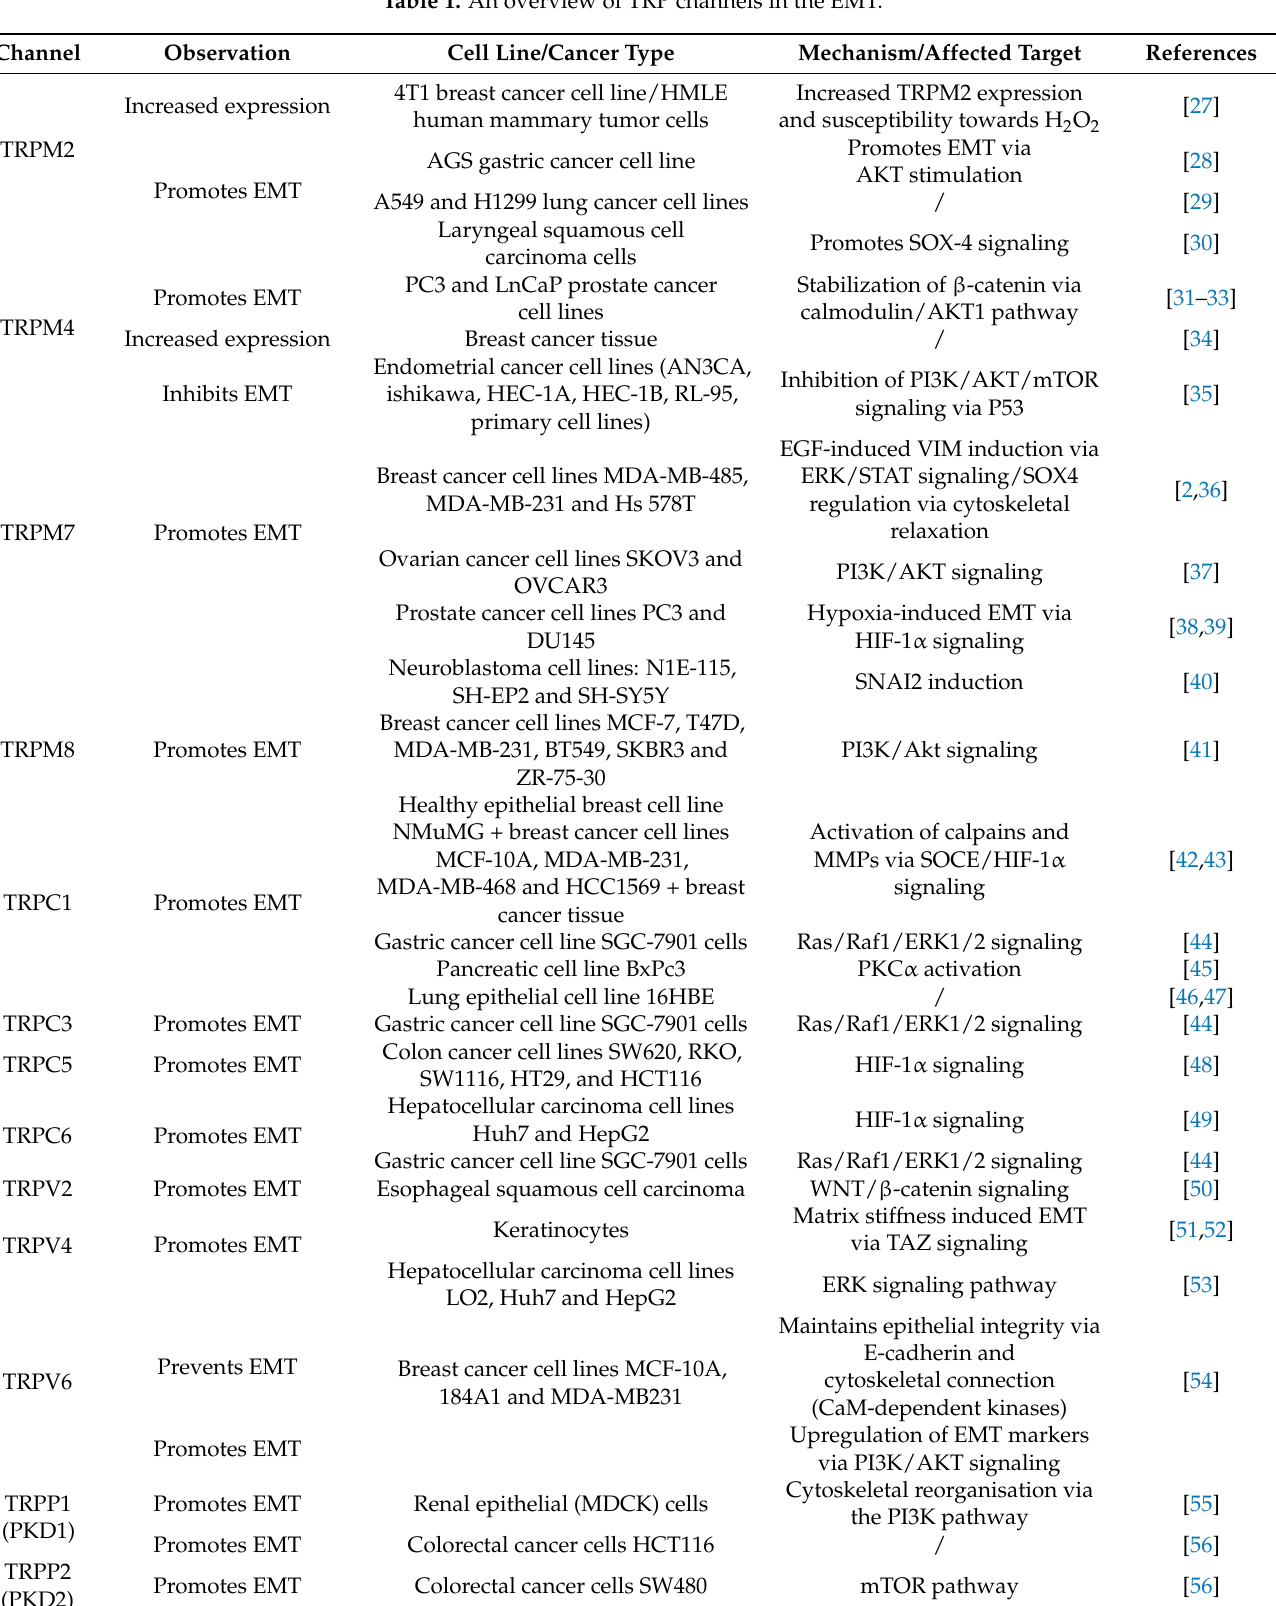
Table 1. An overview of TRP channels in the